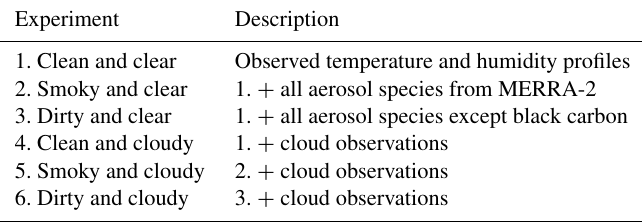
Table 1. Shortwave radiation transfer experiments included in this study.